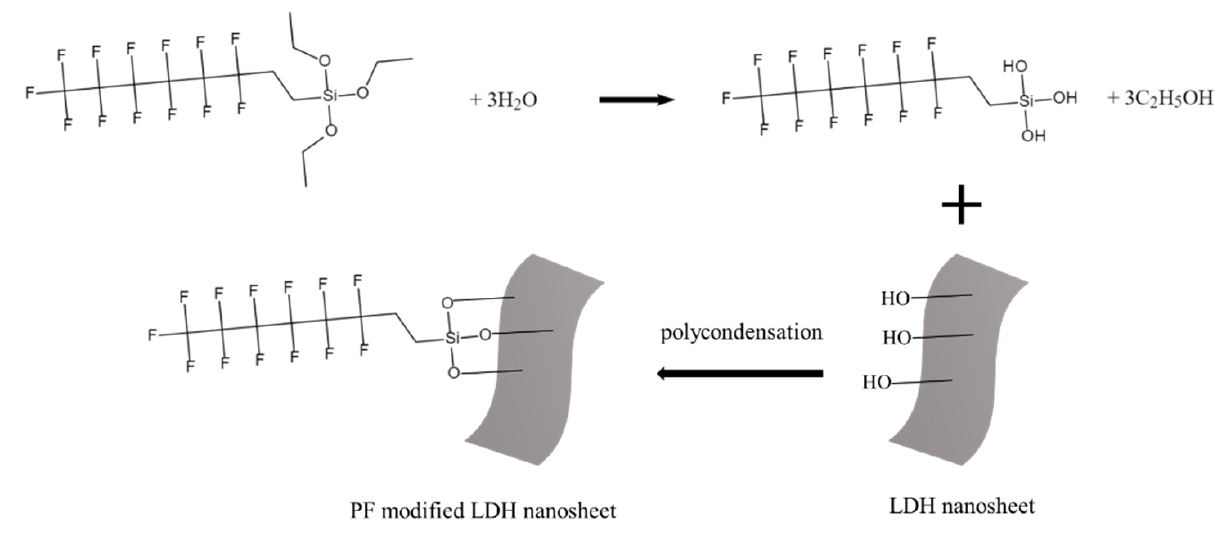
Figure 4. The sketch map of the chemical reactions during the modification process.